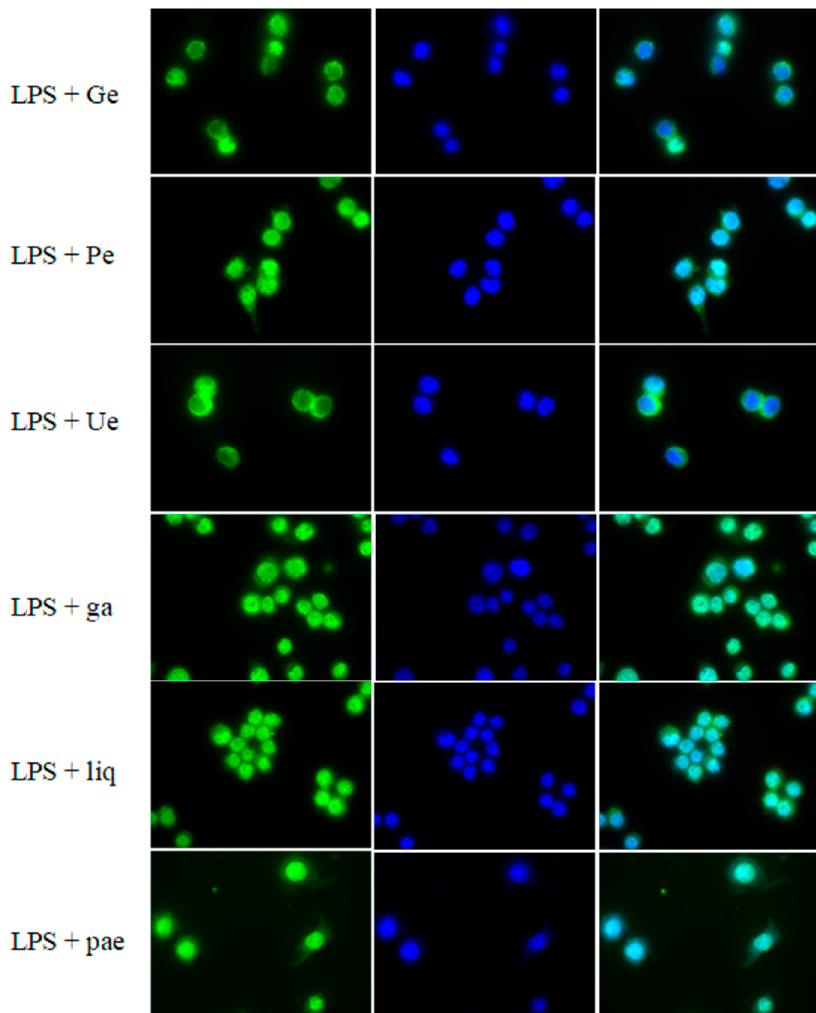
Figure 4. E ff ect of PSMs on the LPS-induced nuclear translocation of NF- κ B. RAW 264.7 cells were treated with LPS or LPS plus plant extracts and PSMs for 2 h. Immunofluorescence and fluorescence microscopy were used to analyze NF- κ B translocation. In the first column, the green color was due to the immunofluorescence of an NF- κ B secondary antibody; the middle column of blue color shows DAPI-dyed nuclei; and the last column was a merge of the first two columns. When NF- κ B moved to the nucleus, the merged nuclei showed a bright white color. The results are expressed as the mean ± SD from at least three independent experiments. (The plotting scale is showed in the control group with p65 staining).